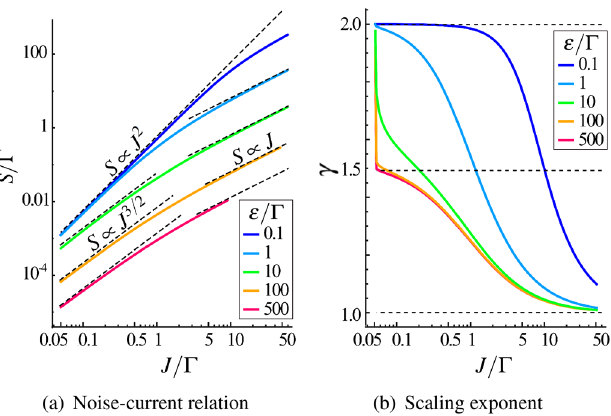
Figure 4. ( a ) Results for scaling exponent γ in noise-current relation S J and anharmonicity ε . Color map represents logarithmic derivative γ crossover between Lorentzian and Gaussian pseudothermal light. The Lorentzian light corresponds to single- particle transport with Breit-Wigner transmission and γ the shot noise. The fractional γ ( b ) Color map for Fano factor F contour.